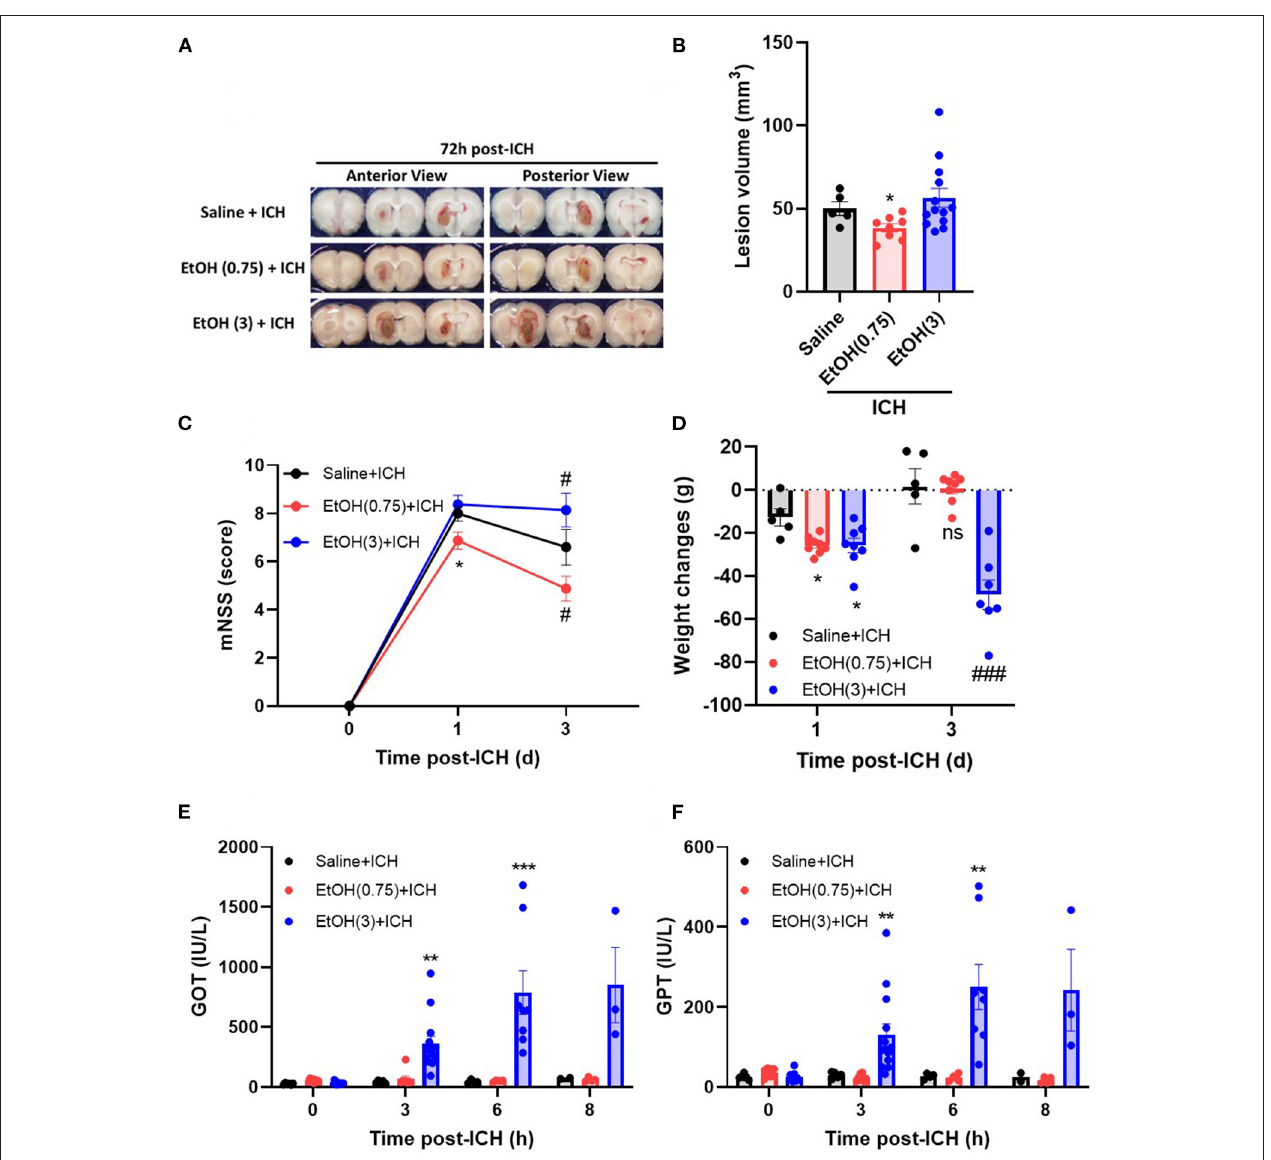
FIGURE 1 | Effect of EtOH pre-conditioning on ICH-induced neurological deficits and liver functions. (A,B) Representative coronal sections (A) showed hemorrhagic brain areas, and lesion volumes (B) were determined by morphometric measurement on day 3 post-ICH. Values are shown as mean ± SEM ( n = 8–14). * p < 0.05 in comparison with Saline + ICH group. (C,D) Modified neurological severity scores (mNSS) (C) and weight changes (D) were assessed on days 0, 1, and 3 post-ICH. Values are shown as mean ± SEM ( n = 5–7). * p < 0.05 as compared to day 1 saline + ICH group. # p < 0.05 as compared to day 3 saline + ICH group. (E,F) Serum levels of GOT (E) and GPT (F) were determined on 0, 3, 6, and 8h post-ICH. Values are shown as mean ± SEM ( n = 5–7). ** p < 0.01 and *** p < 0.001 as compared to saline + ICH group. ### p < 0.001 as compared to saline + ICH group on day 3.